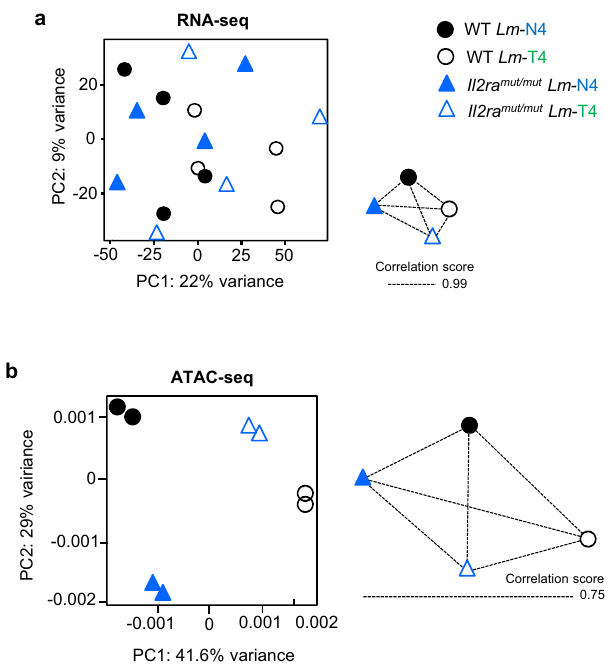
Fig. 5 TCR and IL-2 signals alter chromatin remodeling but not gene expression in memory CD8 + T cells. Il2ra mut/mut and WT OT-I cells were adoptively transferred to WT recipient mice, and infected the next day with Lm -Ova N4 or T4. 4 weeks later, OT-I memory cells were sorted by FACS and processed for RNA-seq and ATAC-seq analysis. Principal component analysis (PCA) of ( a ) RNA-seq and ( b ) ATAC-seq datasets. Correlation network of similarity between each condition in gene expression (RNA-seq) or chromatin accessibility (ATAC-seq) is also shown. Edge length corresponds to similarity (Pearson correlation). RNA-seq ( n = 4 mice) and ATAC-seq ( n = 3 – 4 mice) results were summarized from 2 independent replicates of experiments. Each symbol represents one